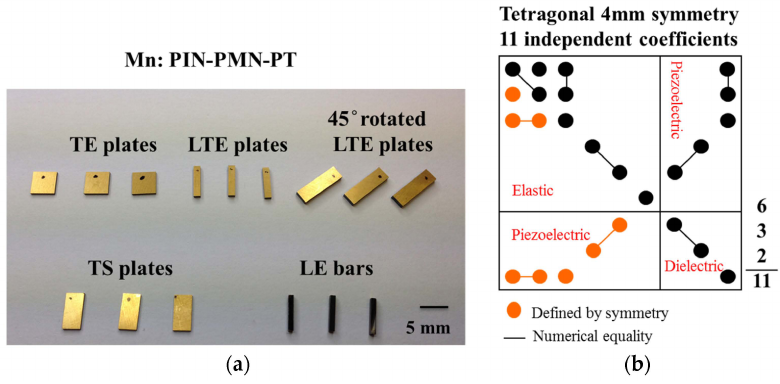
Figure 1. ( a ) Sample set of Mn:PIN-PMN-PT for full elastoelectric matrix; ( b ) Dependence of elastic, piezoelectric and dielectric constants for 4 mm symmetry in full elastoelectric